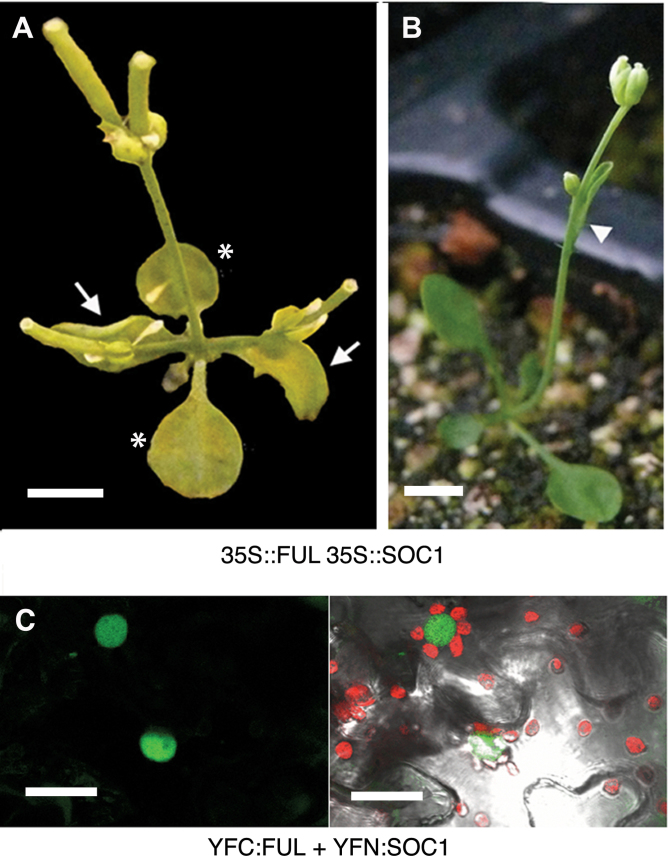
Interaction of FUL with SOC1. (A, B) Phenotypes of 35S::FUL 35S::SOC1 double over-expression lines. Only two rosette leaves are produced (arrows in A) and occasionally one cauline leaf (arrowhead in B). All axillary meristems are determinate, directly producing flowers. Asterisks mark the cotyledons in (A). (C) Bimolecular Fluorescence Complementation in tobacco epidermal leaf cells between transiently expressed FUL and SOC1 fusions to the C- and N-terminal fragments of YFP, respectively. The left panel shows reconstituted YFP fluorescence (green) and the right panel is an overlay with a bright field image of the same sector where chlorophyll is shown in red. Negative controls for BiFC experiments are shown in Supplementary Fig. S3 at JXB online. Scale bars: 500mm (A, B), 40 µm (C).